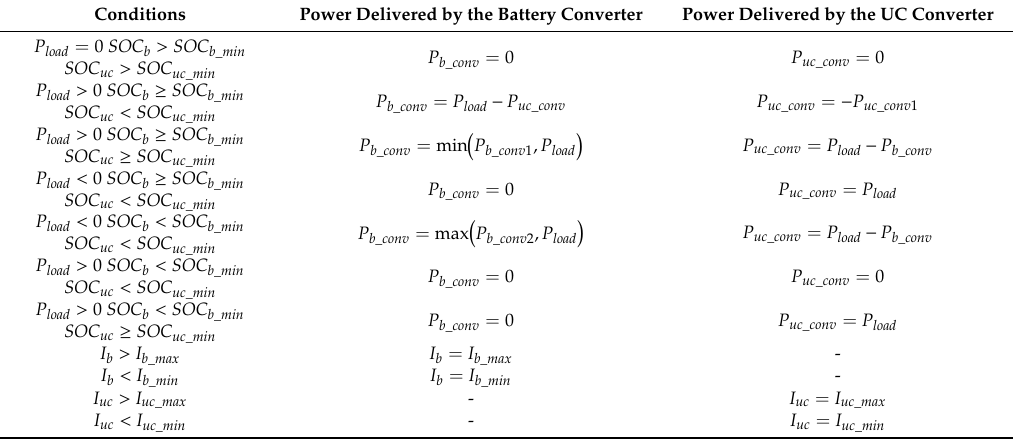
Table 3. Energy management